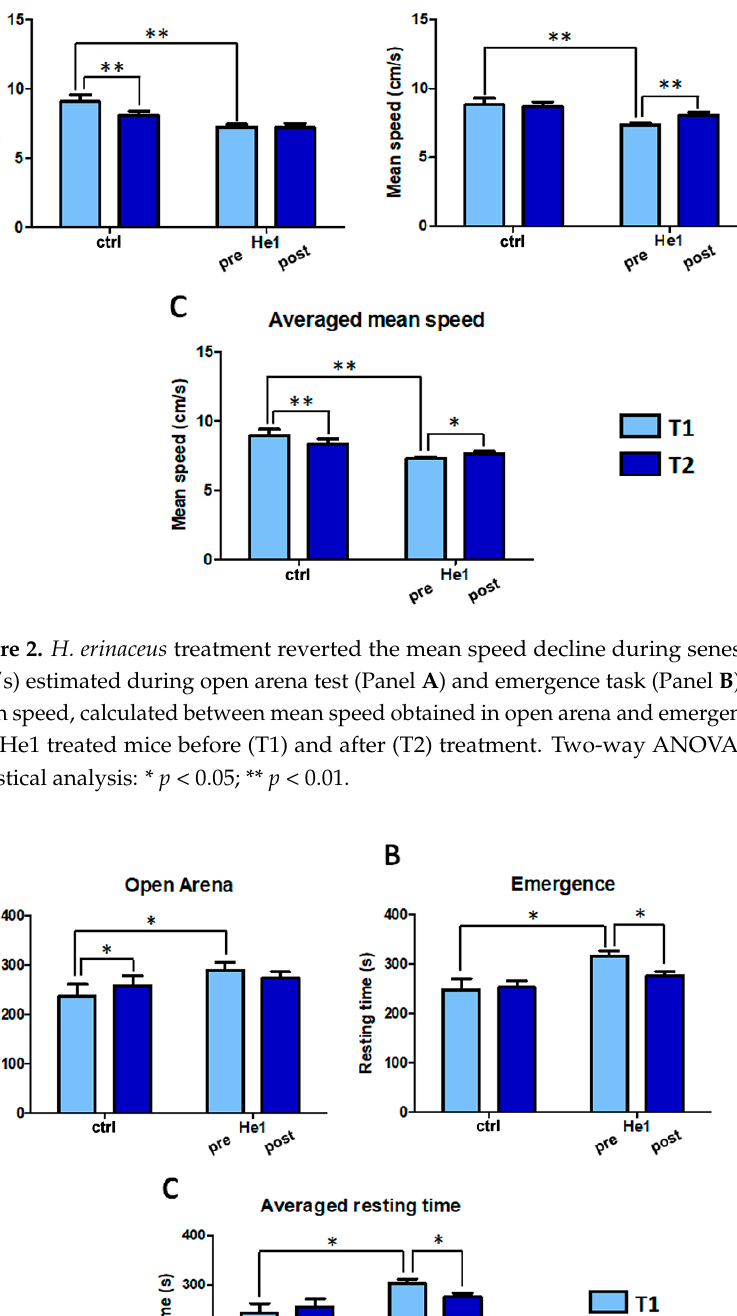
Figure 4. Locomotor frailty index in untreated and He1 treated mice at T1 and T2. Two-way ANOVA was performed for statistical analysis: * p > 0.05; ** p < 0.01. 2.3. H. erinaceus Effect on Cerebellar Cytoarchitecture, Neuroinflammation and Oxidative Stress Pathway Histochemical and immunohistochemical reactions were conducted on sagittal sec- tions of the cerebellar vermis from both untreated (Ctrl) and Hericium -treated mice (He1) at T2 (23,5-month-old mice). The evaluations were performed on the posterior region, spe- cifically on the neocerebellar lobules VI–VIII, known to be particularly impacted by age and correlated with general cognitive and motor function [56–59]. 2.3.1. H&E and Nissl Staining We evaluated the cerebellar volume together with morphological characteristics of cerebellar cortex, exploiting potential cytoarchitecture alterations, comparing senescent